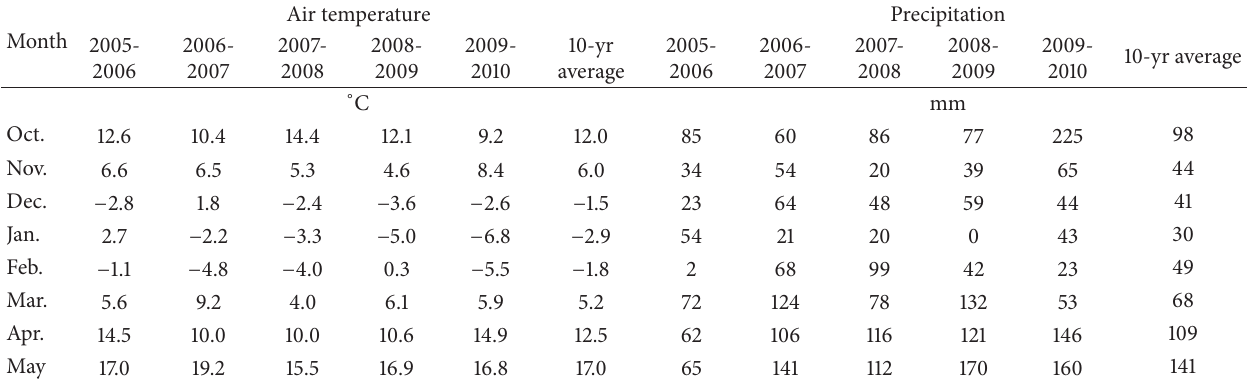
Table 2: Mean monthly air temperature and total monthly precipitation at Novelty from 2006 to 2010, and 10-year average (2001 to 2010). Air temperature Month